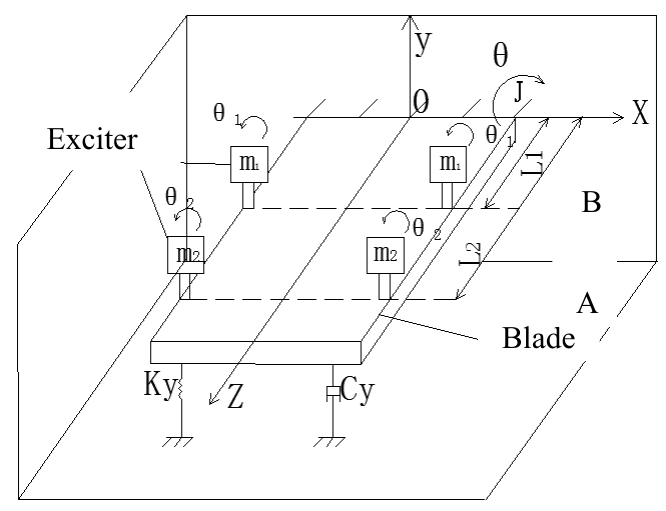
Figure 4. The dynamic model of the multi-point excitation system. According to the analysis of the motion characteristics of the system, it is known that the blade swings around the x -axis while dynamic mass reciprocates in the vertical